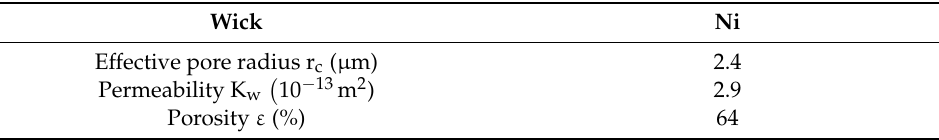
Table 2. Wick internal parameters measurement results.